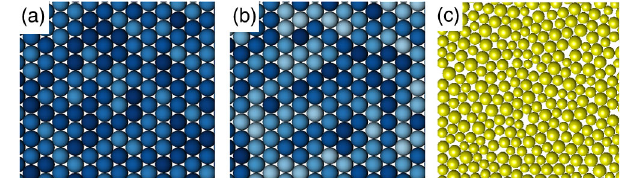
FIG. 1. Granular systems studied in this work: (a) hexagonal lattice with small mass disorder, (b) hexagonal lattice with large mass disorder, and (c) amorphous packings close to the jamming- unjamming transition.